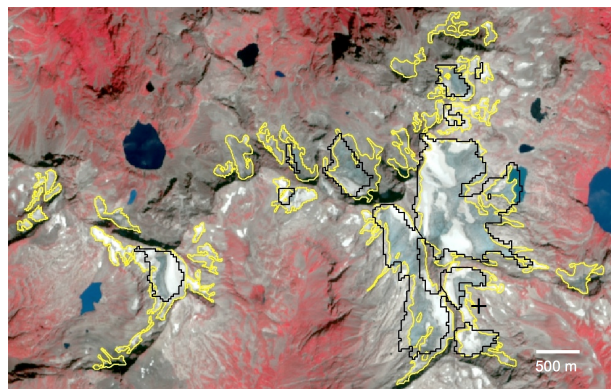
Figure 10. Overlay of glacier outlines from 2003 (black) and 2016 (yellow) showing the different interpretation of glacier extents for the region around Sonnblickkees (SBK) in Austria. The black cross on the lower right marks the coordinates 47.12 ◦ N, 12.6 ◦ E (image source: Copernicus Sentinel data